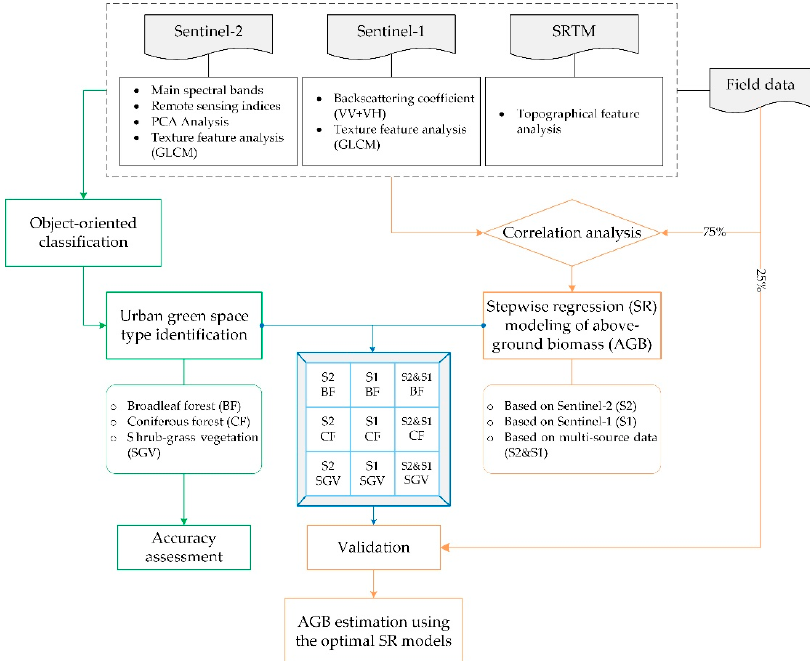
Figure 2. Technical flowchart of UGS type identification and AGB estimation: gray and black indicate the data collected, green indicates the process of UGS type identification, orange indicates the process of AGB estimation, and blue indicates the models built to estimate AGB for different UGS types using different data combinations.